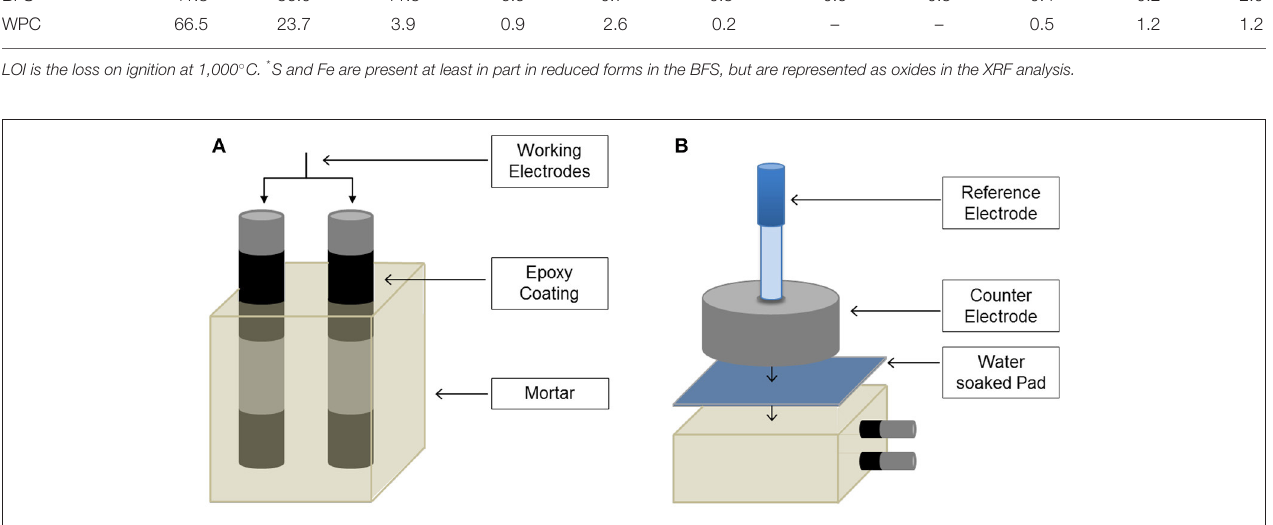
Figure 1B . The steel bars embedded in the prismatic mortar specimens acted as working electrode and a stainless steel cylinder (acting as counter electrode) was placed above the mortar. The counter electrode had the same size as the mortars, achieving a uniform distribution of current lines, and a centrally drilled hole where an Ag/AgCl (filled with 3 M